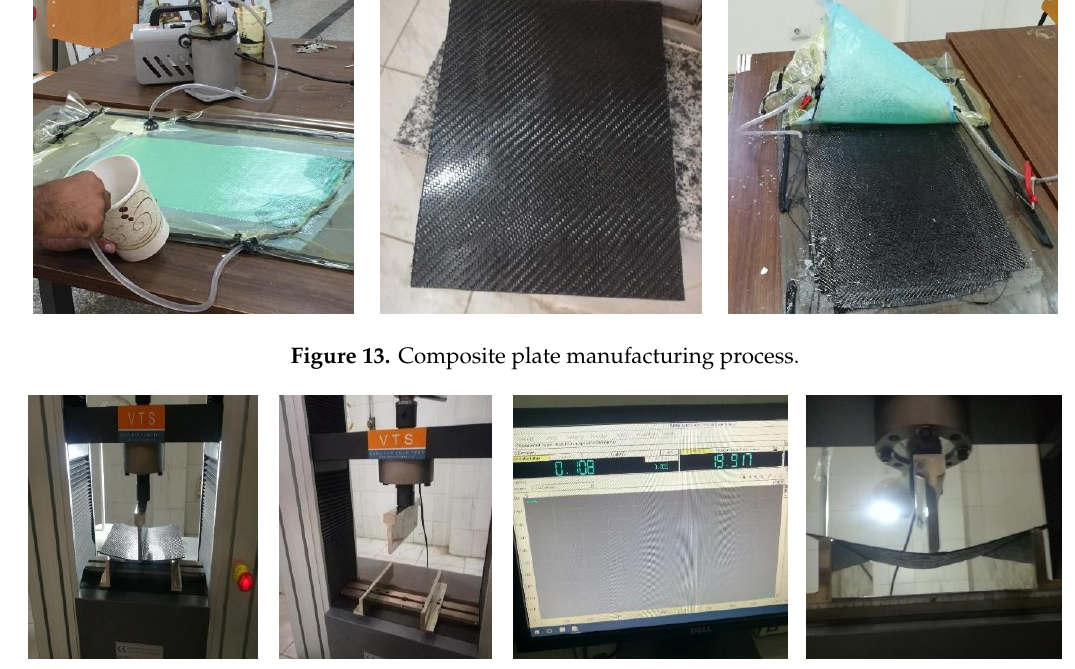
Figure 14. Three-point bending test.